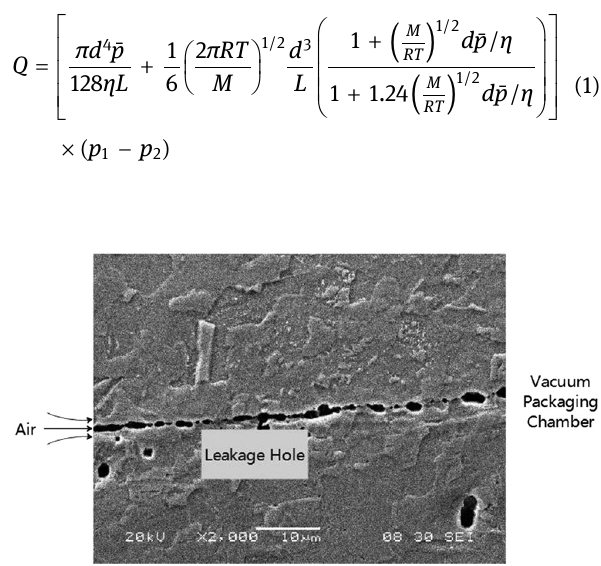
Figure 2: Cross - sectional SEM image of a typical leakage hole in a vacuum packaging